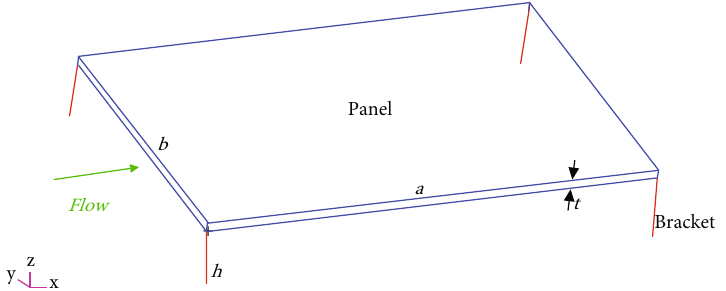
Figure 3: Rectangular panel